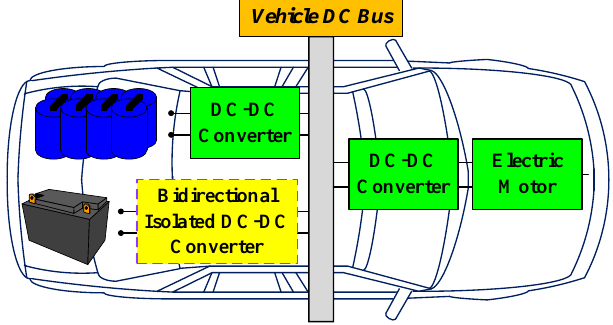
Figure 2. Hybrid energy source of a PHEV.